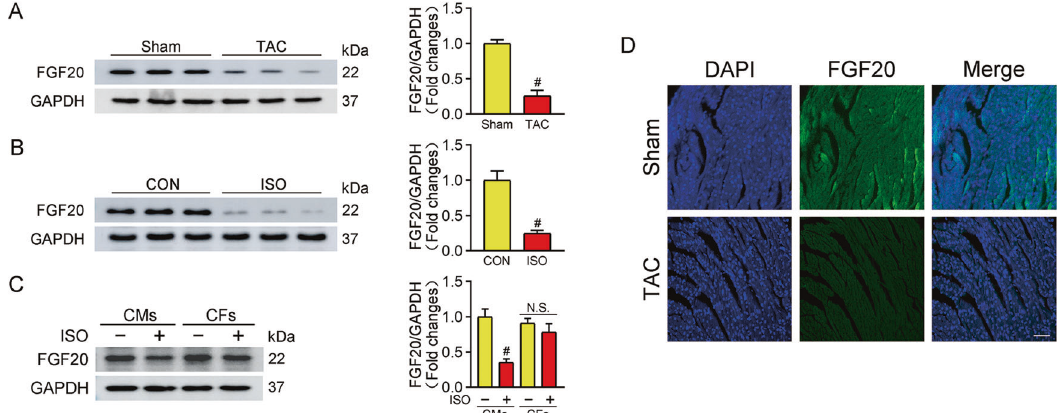
Fig. 1 FGF20 expression is decreased in cardiac hypertrophy. A Western blot was performed and quantitatively analyzed to determine the protein levels of FGF20 in the hearts from TAC-induced cardiac hypertrophic mice and sham-operated controls. n = 5 per group. # P < 0.05 versus Sham group. B Western blot was performed and quantitatively analyzed to determine the protein levels of FGF20 in NRCMs with or without ISO treatment (10 μ M) for 48 h. n = 5 per group. # P < 0.05 versus CON group. C Western blot was performed and quantitatively analyzed to determine the protein levels of FGF20 in NRCMs and NRCFs with or without ISO treatment. n = 5 per group. # P < 0.05 versus CON group. D Representative immuno fl uorescence and quantitative analysis of FGF20 proteins in the heart tissues from sham or TAC mice (Scale bar = 50 μ m). n = 5. # P < 0.05 versus Sham group. Data represent means ± SEM. Two-tailed Student ’ s t